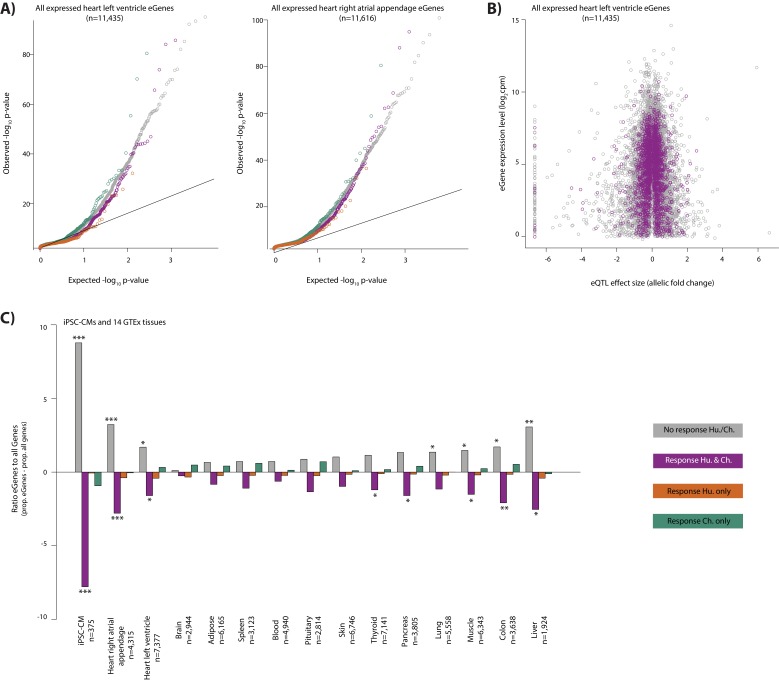
Conserved response genes are depleted for eGenes across tissues.(A) QQ-plot representing all eGenes in heart left ventricle and heart right atrial appendage (GTEx Consortium) that overlap each response category. (B) The relationship between the heart left ventricle eQTL effect size, and mean expression level of the corresponding eGene, for genes in the conserved and non-response categories. (C) The proportion of eGenes in 14 GTEx tissues and iPSC-derived cardiomyocytes (iPSC-CM) (Banovich et al.) in each response category relative to the proportion of all genes in each response category. Response categories are: non-response (grey), conserved response (magenta), human-specific response (orange), and chimpanzee-specific response (green). Asterisk denotes a significant difference between the proportion of eGenes in each response category, and the proportion of all genes within a response category (*p<0.05, **p<0.005, ***p<0.0005).